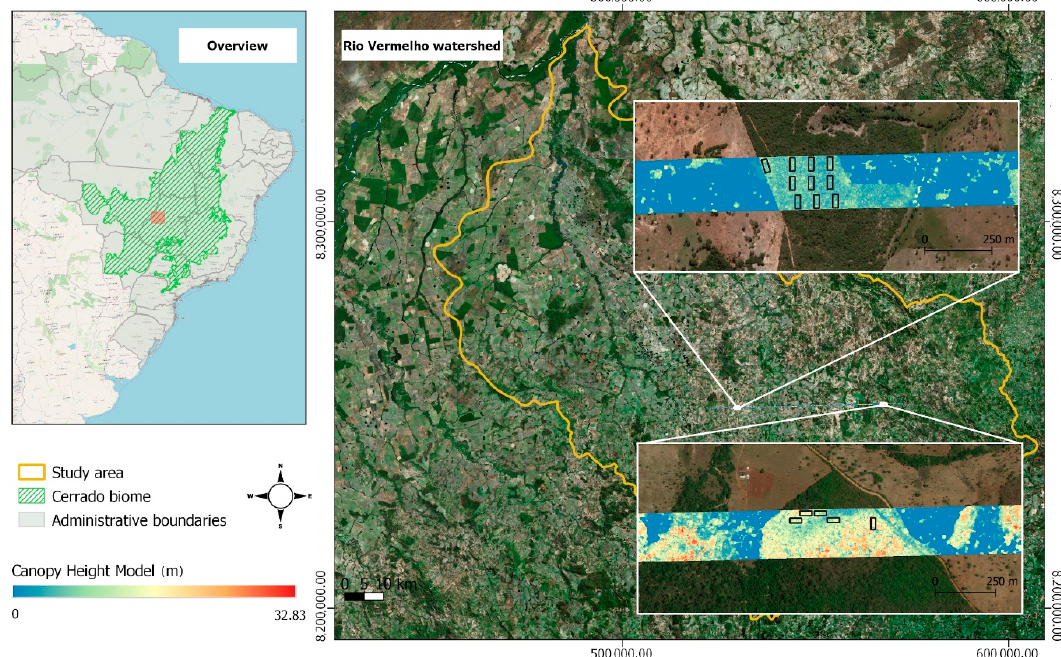
Figure 1. Location of the Rio Vermelho watershed study area (outlined in yellow in the right panel) located in the State of Goiás in Brazil and in the Cerrado biome (grey and green areas in the left overview panel). The location and a zoom of the canopy height light detection and ranging (LiDAR) footprints within the watershed (each of those covered an area of 16.82 ha) with the location of the field plots (black rectangles) are also shown. The entire right panel corresponds to the red square in the left overview panel. The background image corresponds to the © Bing™ aerial photo, a screenshot(s) reprinted with permission of Microsoft Corporation.